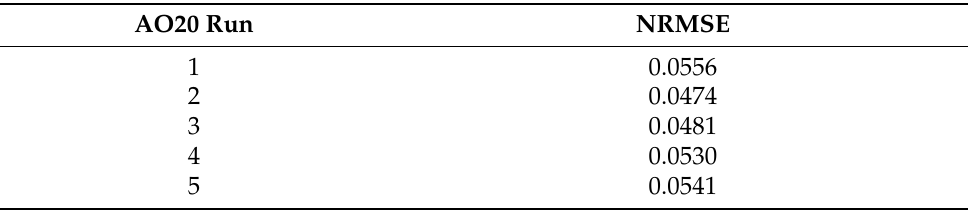
Table 4. Run replicability experiment results. Results are given in RMSE of the normalized error distances